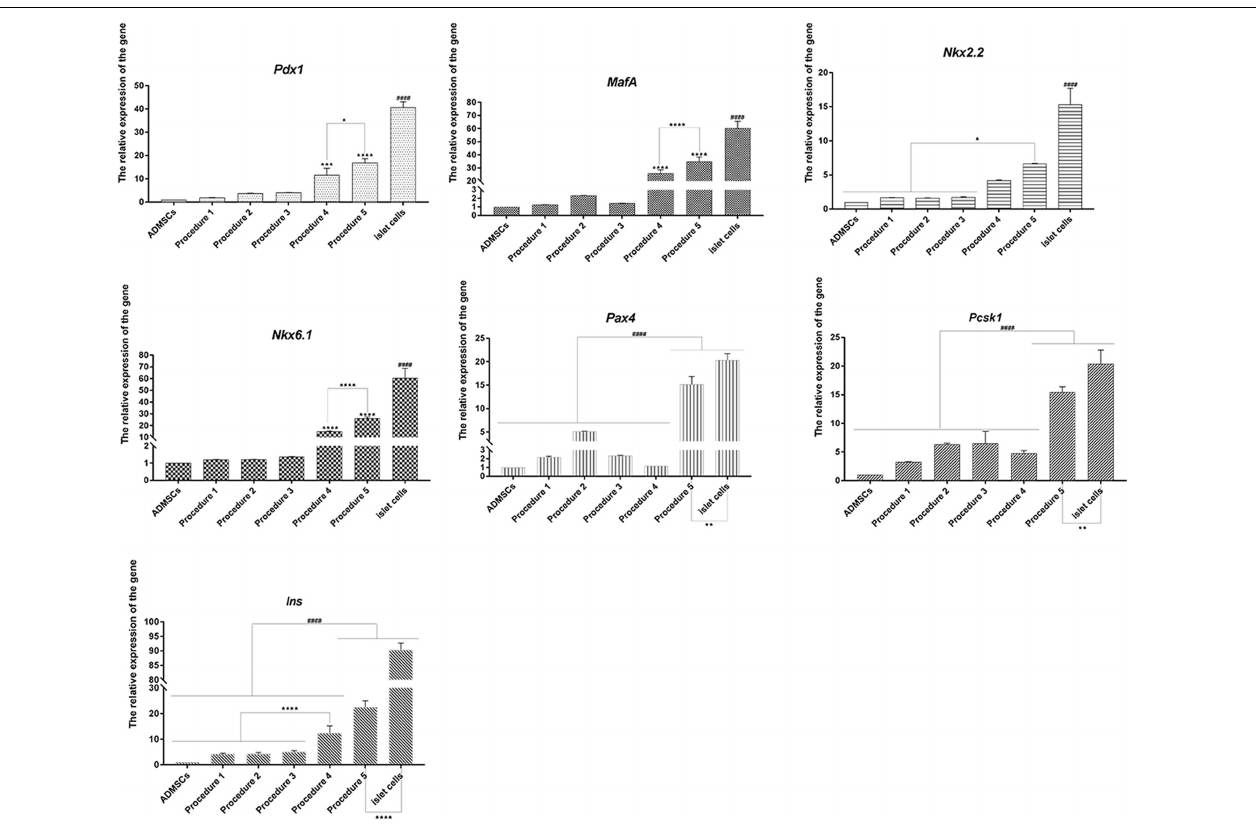
FIGURE 3 | RT-qPCR analysis. The expression level of each gene in procedure 5 was elevated, which was significantly higher than procedures 1, 2, 3, and 4, there is no difference between procedures 1, 2, and 3. The expressions of Pdx1 , MafA , Nkx6.1 , and Ins in procedure 4 were significantly higher than those in procedure 1, 2, and 3 (**** p < 0.0001; *** p < 0.001; ** p < 0.01; * p < 0.05). The expression level of all genes in procedure 1, 2, 3, 4, and 5 was significantly lower than that of mature islet cells (#### p <